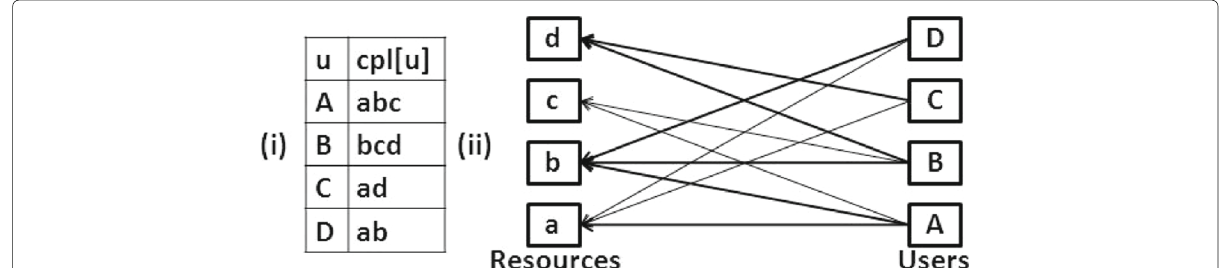
Fig. 5 ( i ) Example CPLs, and ( ii ) A minimal vertex resource